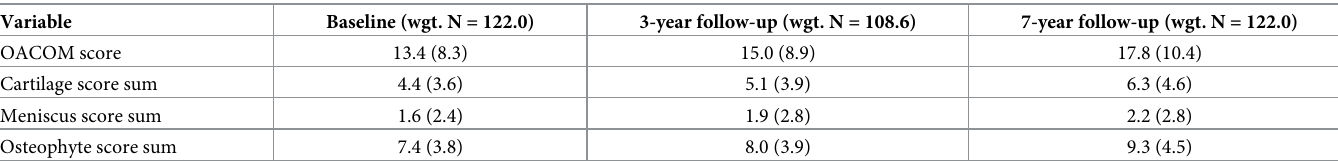
Table 3. Scores per cycle: Mean (SD). Variable